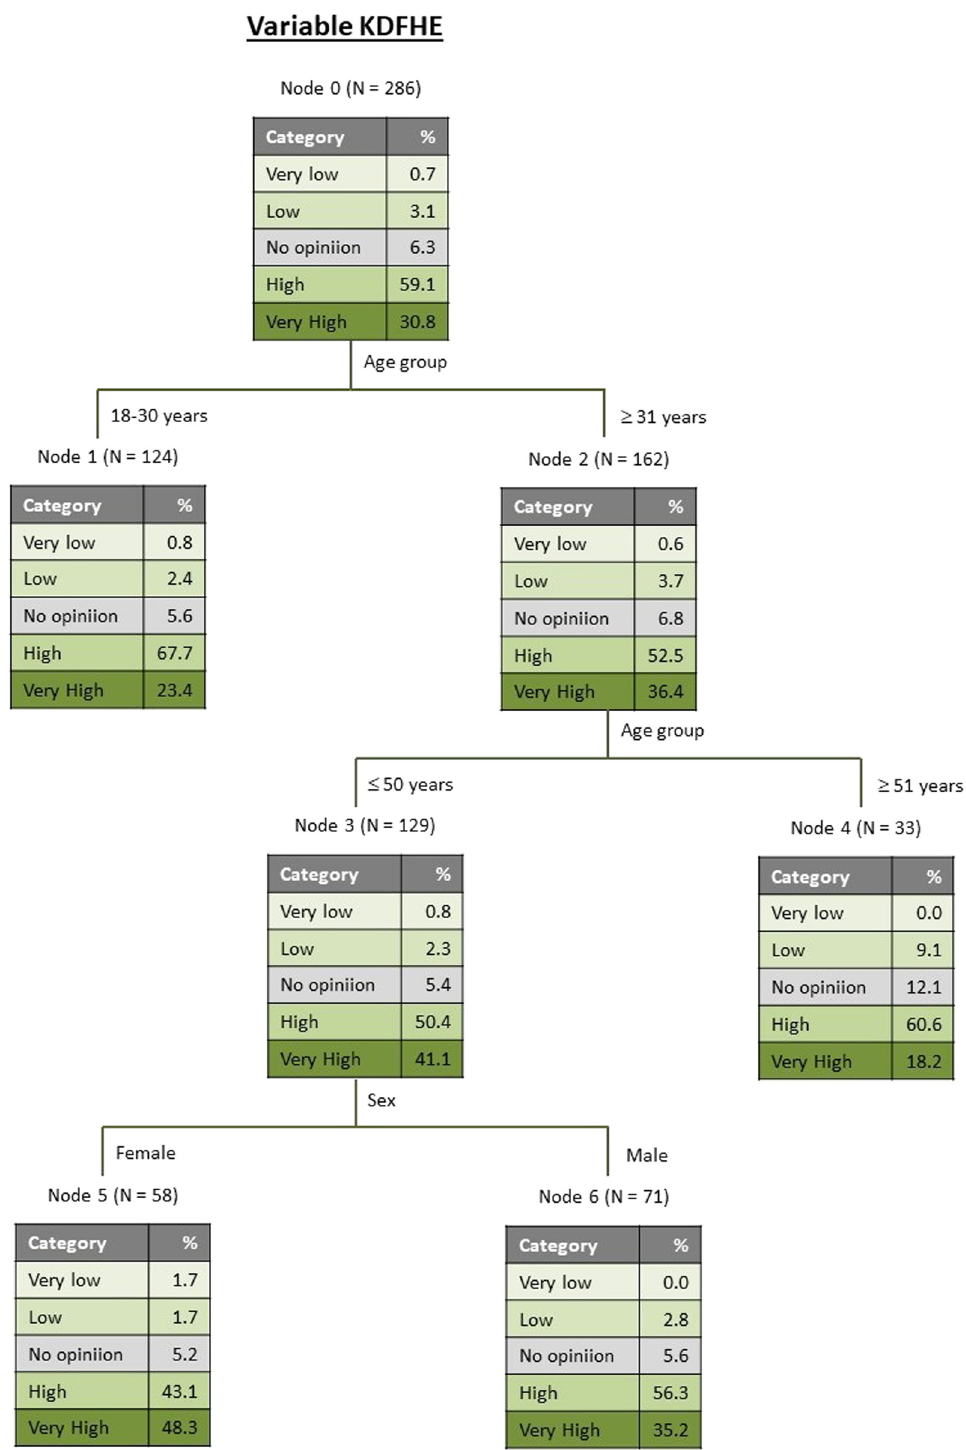
Figure 2: Classi fi cation tree for variable